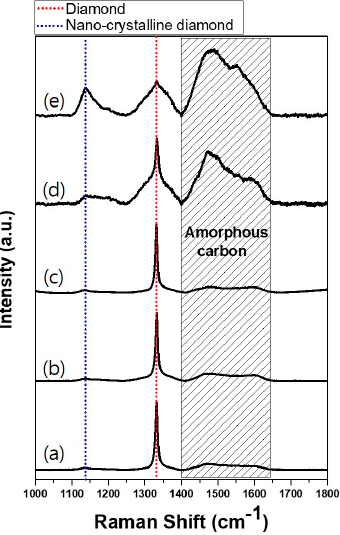
Figure 5. Raman spectra of the diamond films deposited at acetone fluxes of ( a ) 90, ( b ) 130, ( c ) 170, ( d ) 210, and ( e ) 250 sccm.